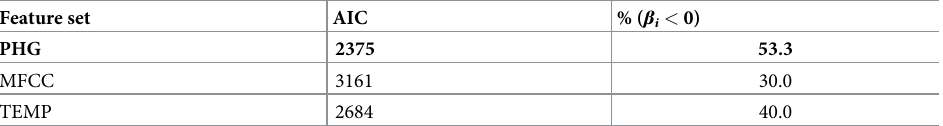
Table 3. Performance for each of the feature sets, in terms of i) the LMER model fit (AIC), and ii) percentage of imitated drum sounds for which the rating * distance slope is significantly less than 0 ( α <